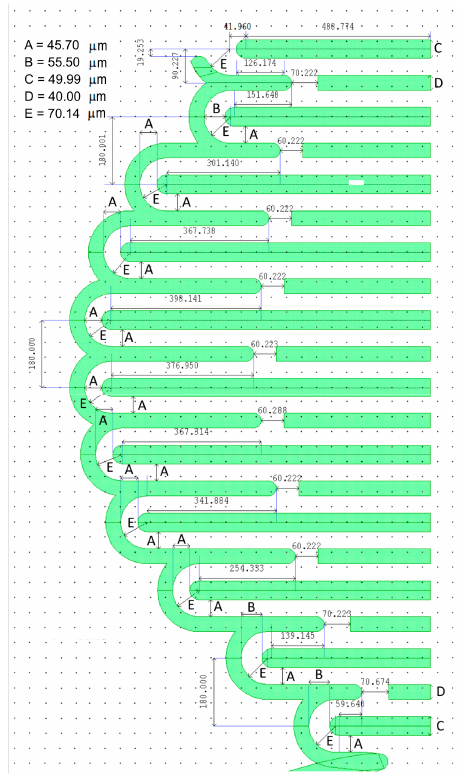
Figure 4. Detailed layout dimensions of the serpentine springs and half of the coubset (the color represents the etching on the device